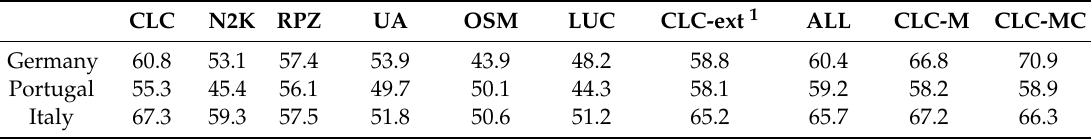
Table 2. Overall accuracy (%) for the di ff erence land use and land cover (LU / LC) data sets and their combinations.